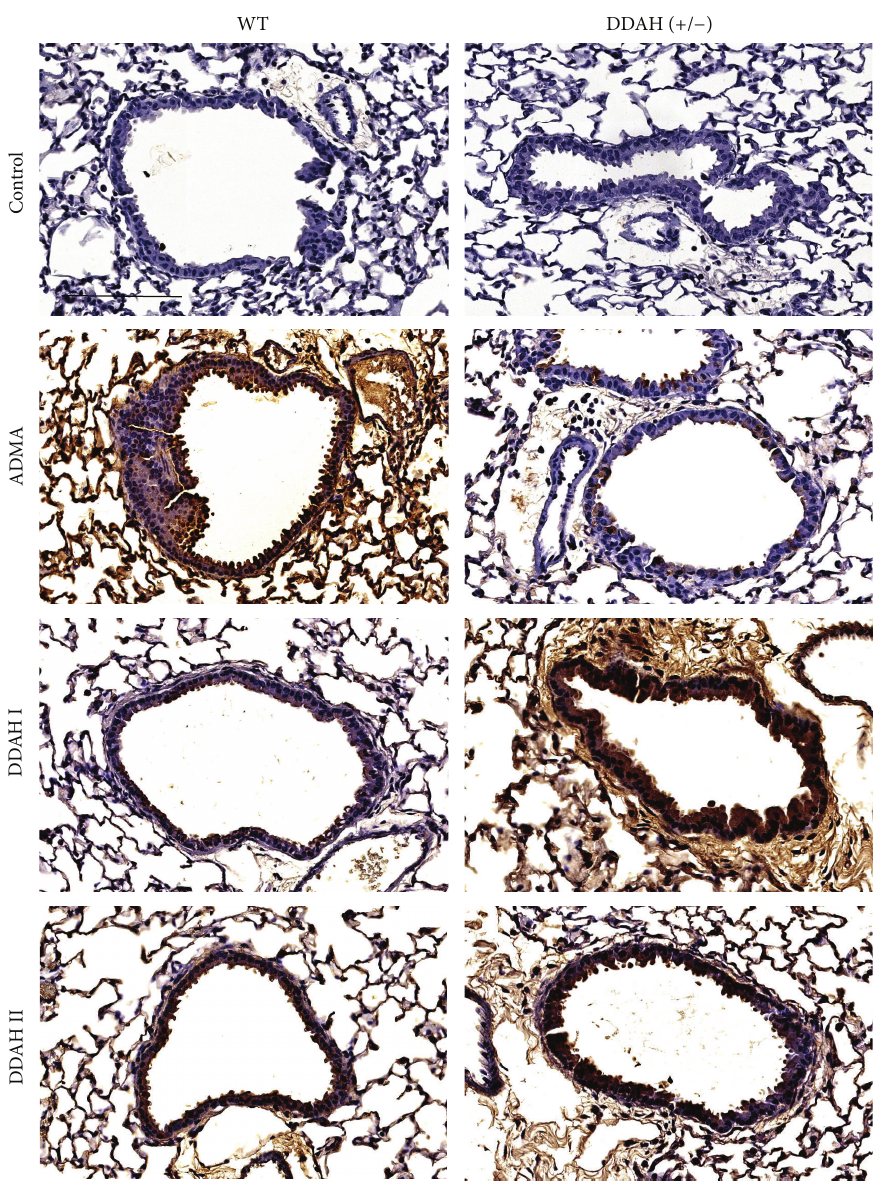
Figure 1: ADMA and DDAH are located in the ciliated cells of the airway epithelium. Free and bound ADMA, DDAH-I, and DDAH- II were immunolocalized in wild type (WT) and DDAH-I overexpressing [DDAH (+/ − )] mouse lung tissue sections and visualized by immunoperoxidase stain. Controls consist of non-specific IgG primary antibody. Original magnification is 40x. Bar represents 100 𝜇